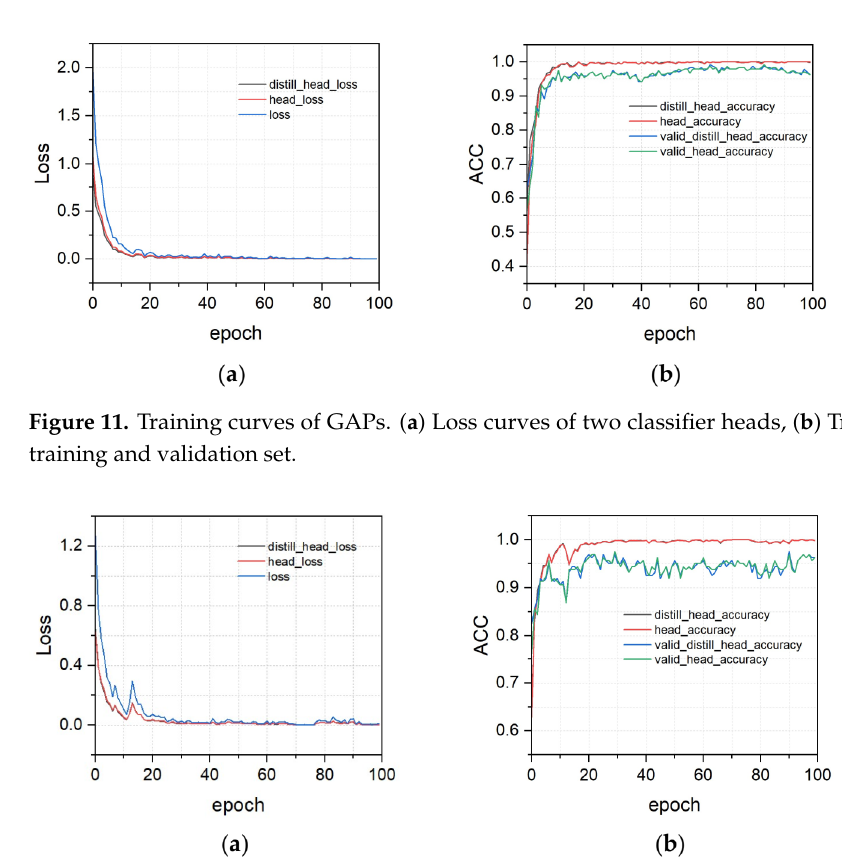
Figure 10. Training curves of JCAPs. ( a ) Loss curves of two classifier heads, ( b ) Training curves of training and validation set.